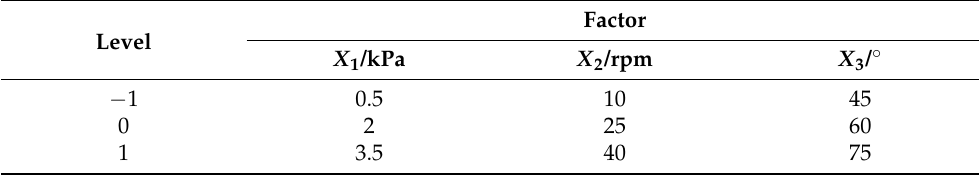
Table 2. Levels of experimental factors. Level